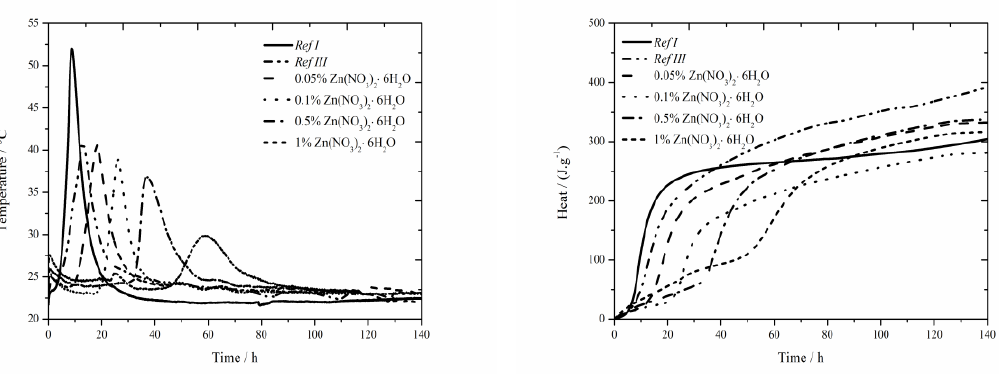
Figure 1. Isoperibolic for Zn(NO 3 ) 2 samples.